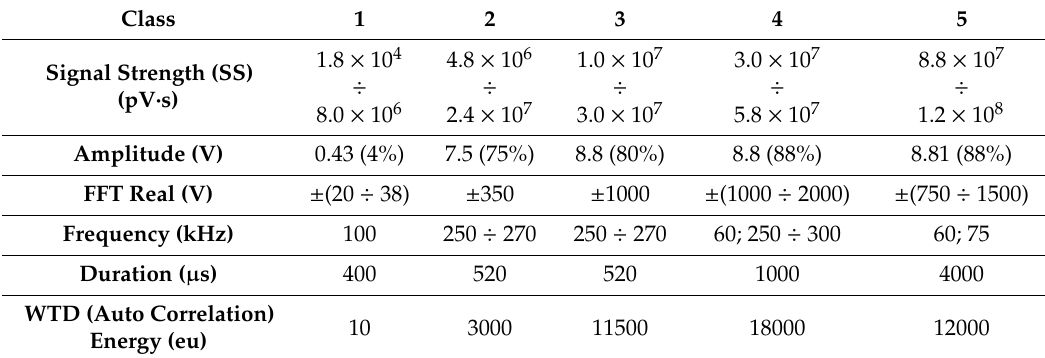
Table 3. Ranges and maximum levels of AE signal